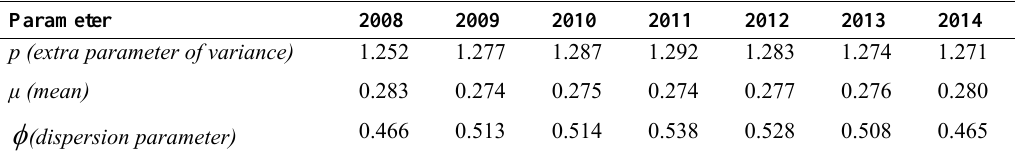
Table 6 : Parameter Estimates for Tweedie Distribution by year